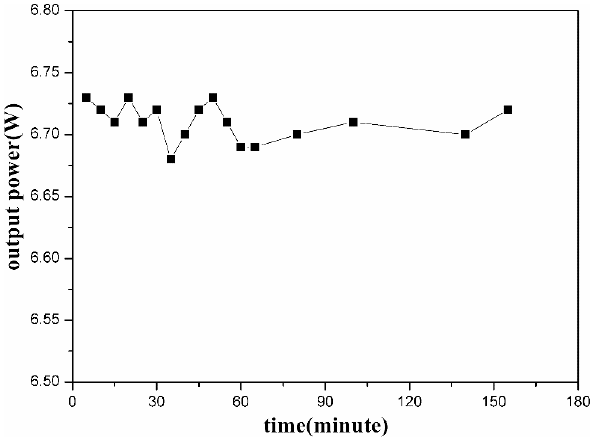
Fig. 7. Output power stability results of the 532-nm laser.